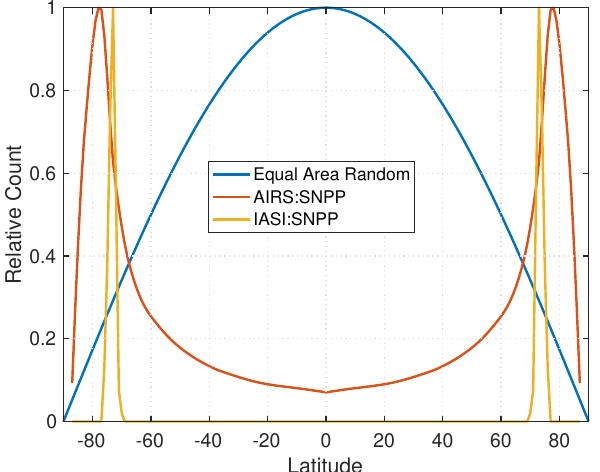
Figure 5. NEdN estimates for the AIRS and CrIS NPP parent CHIRP. The down-interpolation for CrIS parent and the translation for AIRS-parent, together with the Hamming apodization applied to both, have the effect of significantly decreasing NEdN in comparison with the parent measurements.